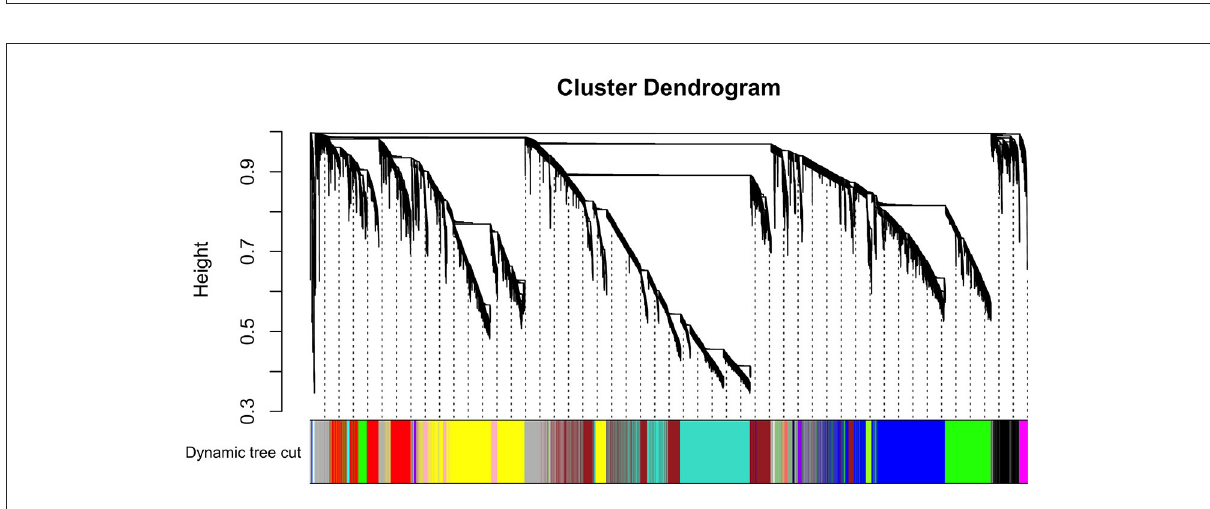
FIGURE5 Hierarchical cluster tree of co-expressed genes and